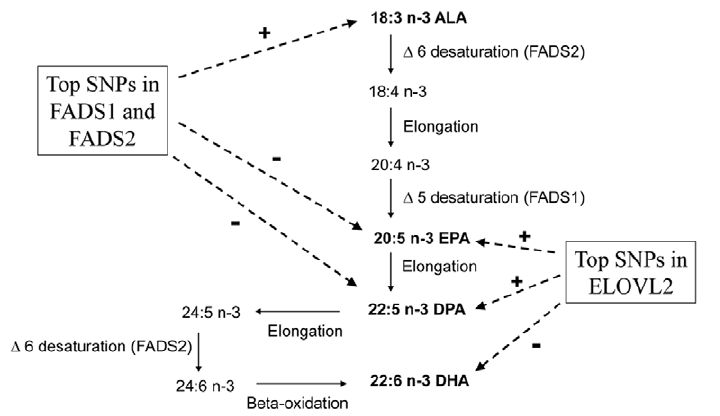
Figure 1. N-3 polyunsaturated fatty acid metabolic pathway and summary of genome-wide associations in pathway. The fatty acids indicated in bold were examined in this study. The genome-wide significant associations of two loci with each fatty acid are shown with dashed arrows. + and 2 signs indicate the direction of the associations.